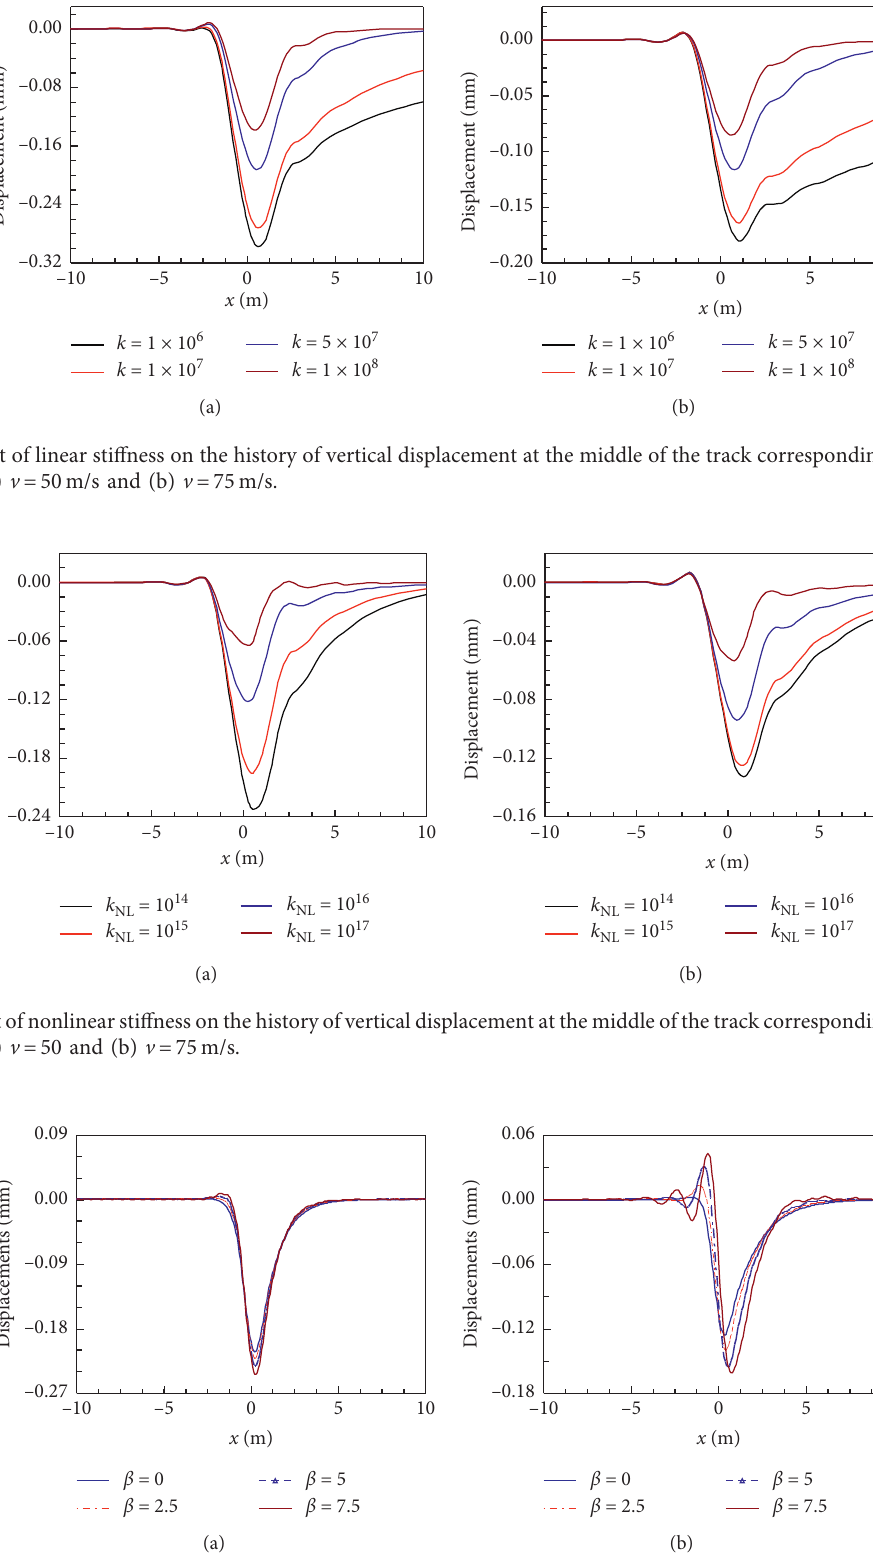
Figure 9: The history of vertical displacements at the middle of the track corresponding with location of the moving vehicle: (a) v � 50 m/s and (b) v �